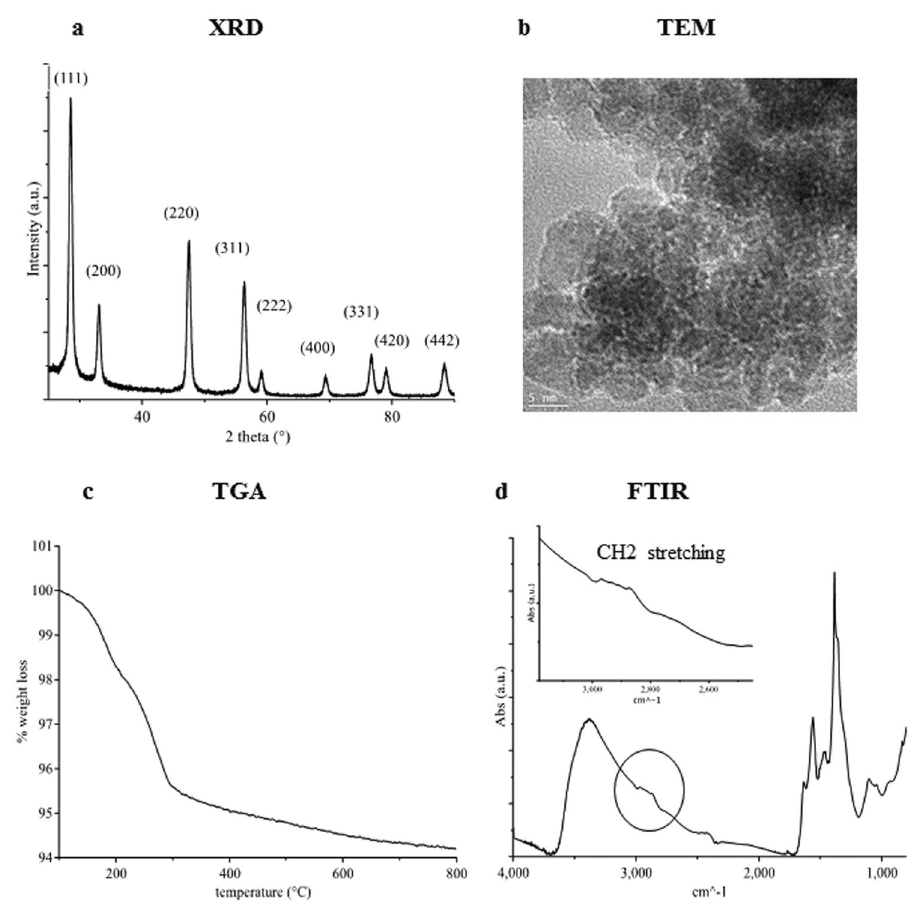
Figure 1. Physico-chemical characterization of C1 nanoparticles. ( a ) XRD diffraction patterns and Miller indexes of C1. ( b ) TEM image. ( c ) TGA curve. ( d ) FTIR absorbance spectra with the inset of the CH 2 stretching